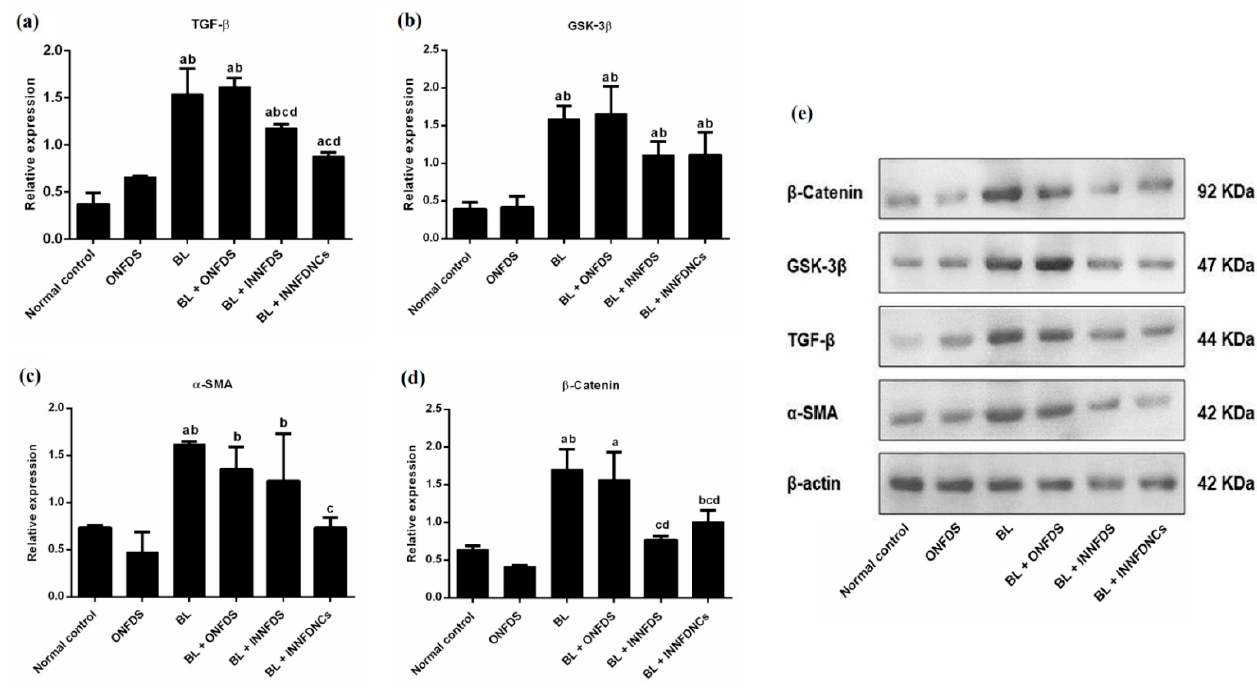
Figure 6. Lung protein expression of TGF- β , GSK-3 β , α -SMA, and β -catenin. ( a ) TGF- β , ( b ) GSK-3 β , ( c ) α -SMA, ( d ) β -catenin and ( e ) Western blot bands of studied proteins versus β -actin. Values are means ± SD, n = 10 for each group. ONFDS: oral nifedipine suspension; BL: bleomycin; INNFDS: inhaled nifedipine suspension; INNFDNCs: inhaled nifedipine nanocomposites; TGF- β : transforming growth factor beta; GSK-3 β : glycogen synthase kinase-3 beta; α -SMA: alpha smooth muscle actin ( a p < 0.05 versus normal control, b p < 0.05 versus ONFDS, c p < 0.05 versus BL, d p < 0.05 versus BL + ONFDS, e p < 0.05 versus BLM + INNFDS).